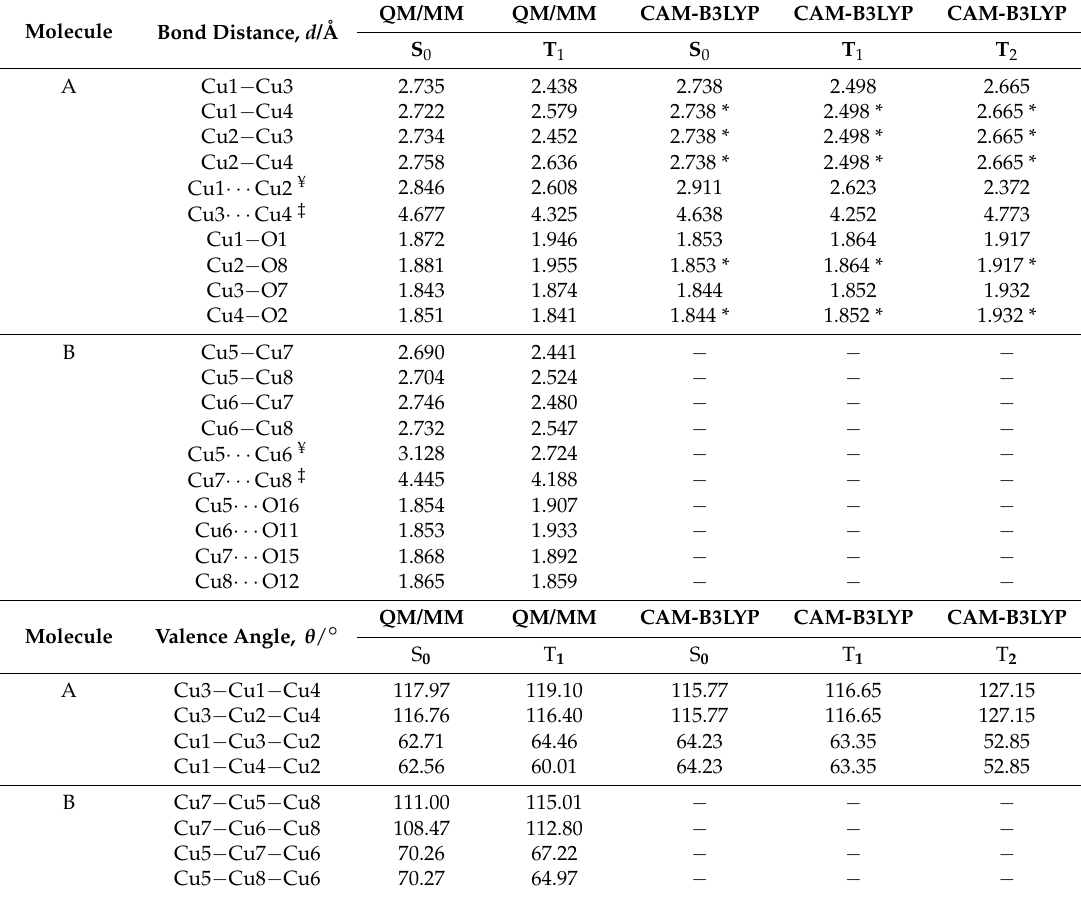
Table 7. Comparison of selected ground (S 0 ) and excited triplet-state (T 1 & T 2 ) geometries. QM/MM denotes modelled solid-state structures; CAM-B3LYP denote theoretical isolated-molecule results (shown only once for molecule A entries). See also Figures S3 and S4 in the Supplementary Materials. Molecule Bond Distance, d